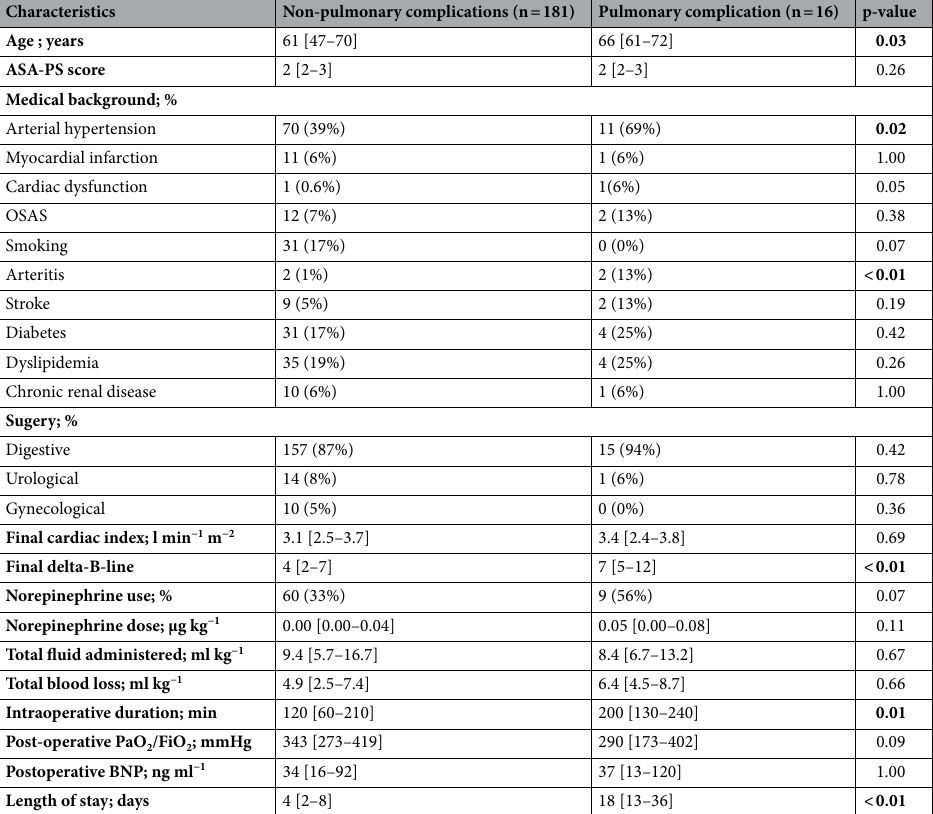
Table 2. Comparison of baseline characteristics, echography, intraoperative, and postoperative parameters as a function of the occurrence of postoperative pulmonary complications. Significant values are in bold. Values are means ± SD, numbers (proportion) or median [IQR]. Digestive surgery duodenopancreatectomy, hepatectomy, colectomy, gastrectomy, oesophagectomy, intraperitoneal hyperthermic chemotherapy. Urological surgery: cystectomy, nephrectomy, Gynecological surgery hysterectomy and ovariectomy, OSAS obstructive sleep apnea syndrome, ASA-PS American Society of Anesthesiology-Physical status, PaO 2 /FiO 2 arterial oxygen partial pressure to fractional inspired oxygen